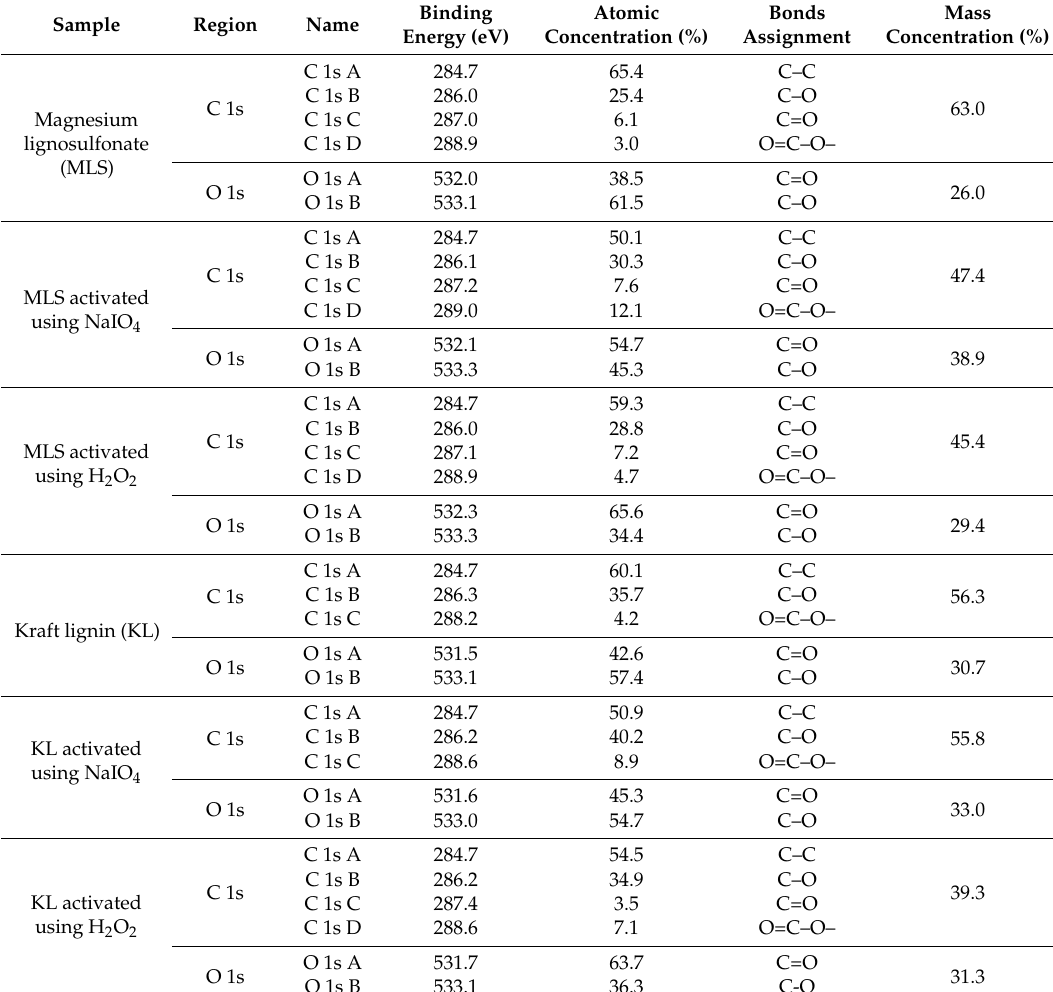
Table 2. Elemental composition of samples examined using XPS